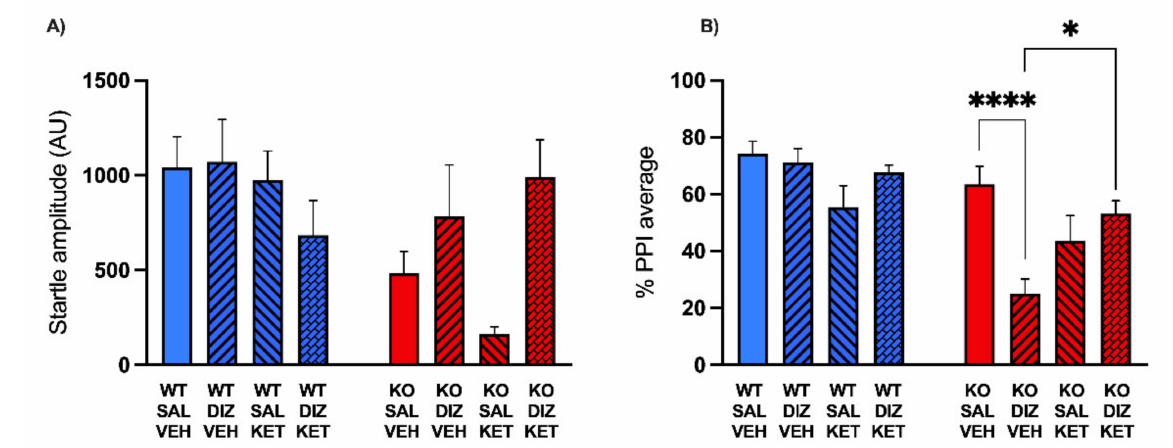
Figure 3. Effects of the systemic administration of ketanserin (KET, 2 mg/kg, IP) on the changes in startle reflex ( A ) and prepulse inhibition ( B ) induced by dizocilpine (DIZ, 0.1mg/kg, IP) in MAOA KO mice. Data are shown as means ± SEM. Significance levels refer to the results of post hoc comparisons of three-way ANOVA analyses. Main effects are not indicated. * p < 0.05, **** p < 0.0001 for compar- isons indicated by bracket lines. (SAL, saline; VEH, vehicle; AU, arbitrary units); n = 6–8/group. For further details, see results section.